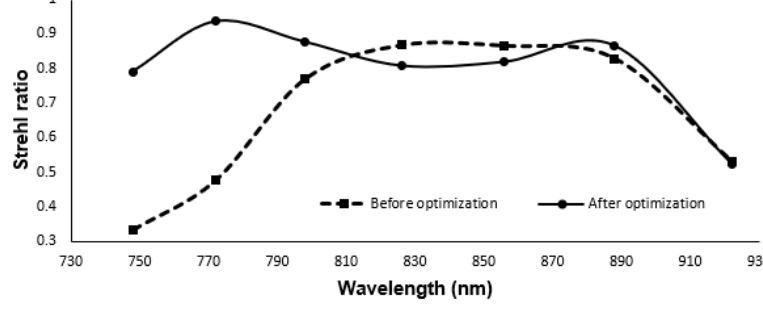
Figure 7. Strehl ratio of the linear spectrometer before and after